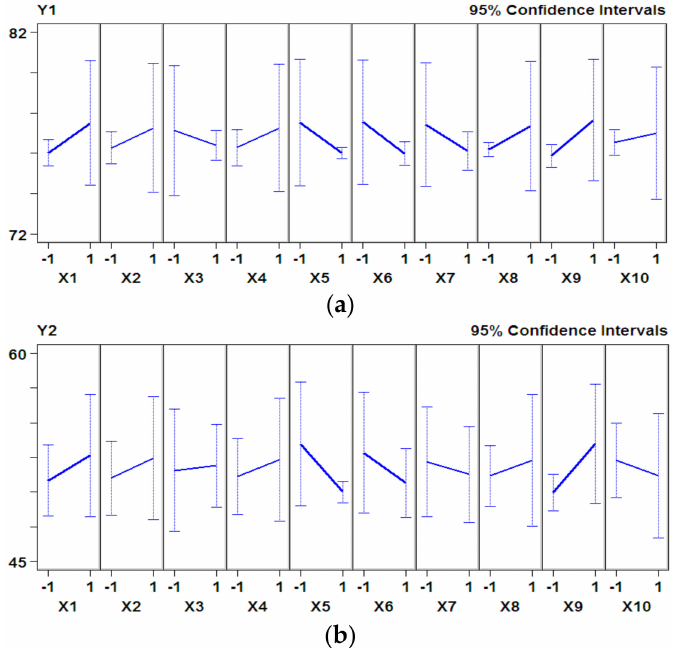
Figure 2. The confidence interval of variable factors for the hydroxyl free radical scavenging rate ( a ) and DPPH radical scavenging rate ( b ).